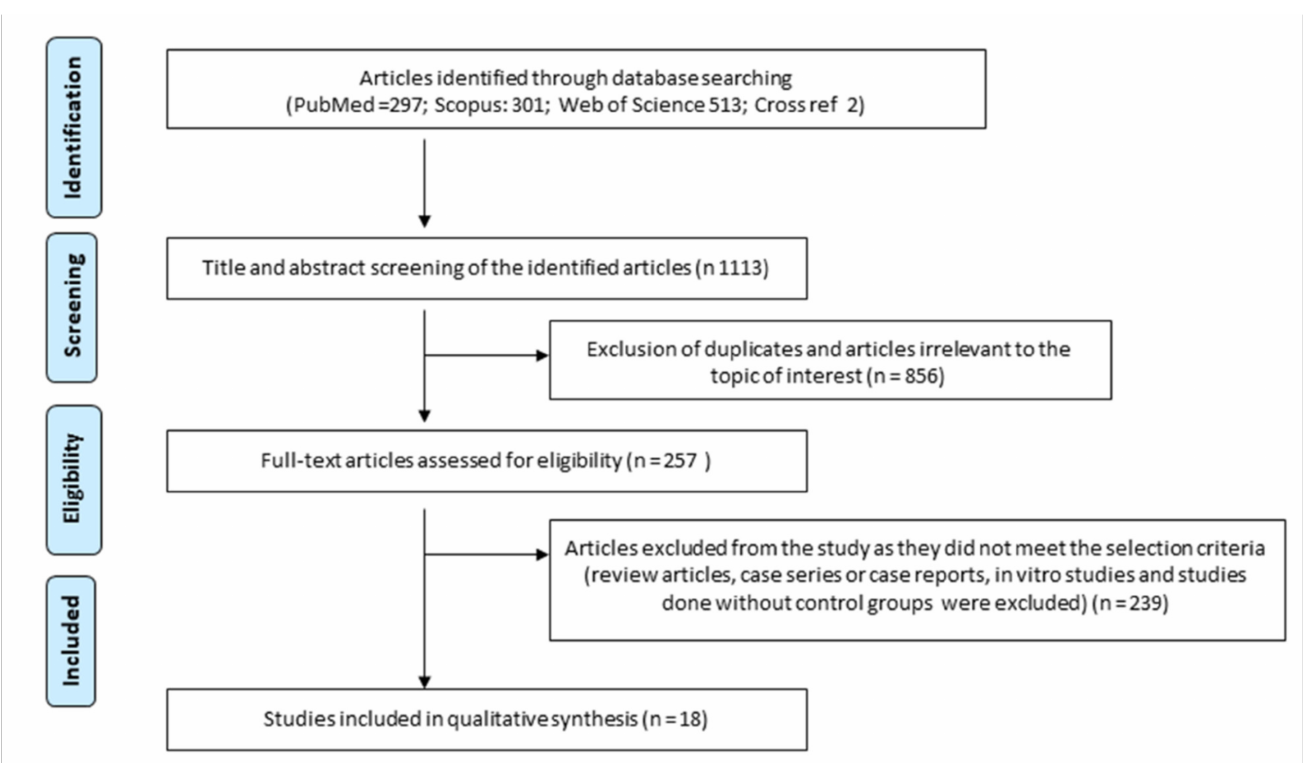
Figure 1. PRISMA flow